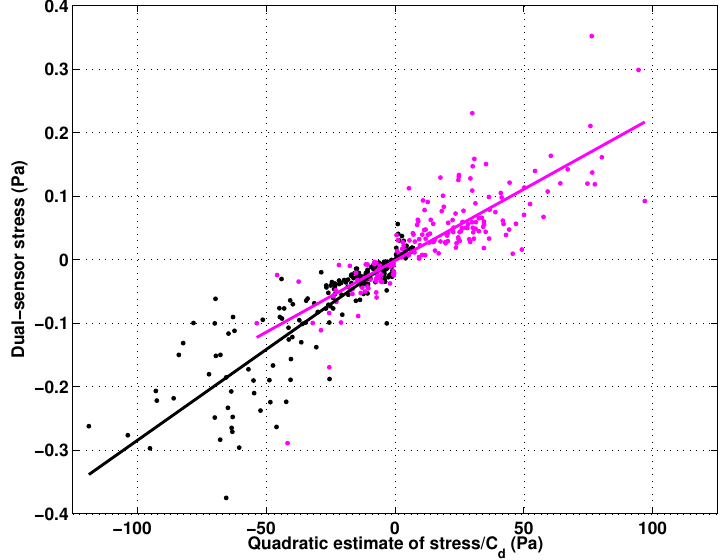
Figure 9. Comparison of the direct estimates of near-bed stress with quadratic drag relation. The black and magentalinesarethelinearleastsquaresregressionsforEast–WestandNorth–Southcomponents,respectively.